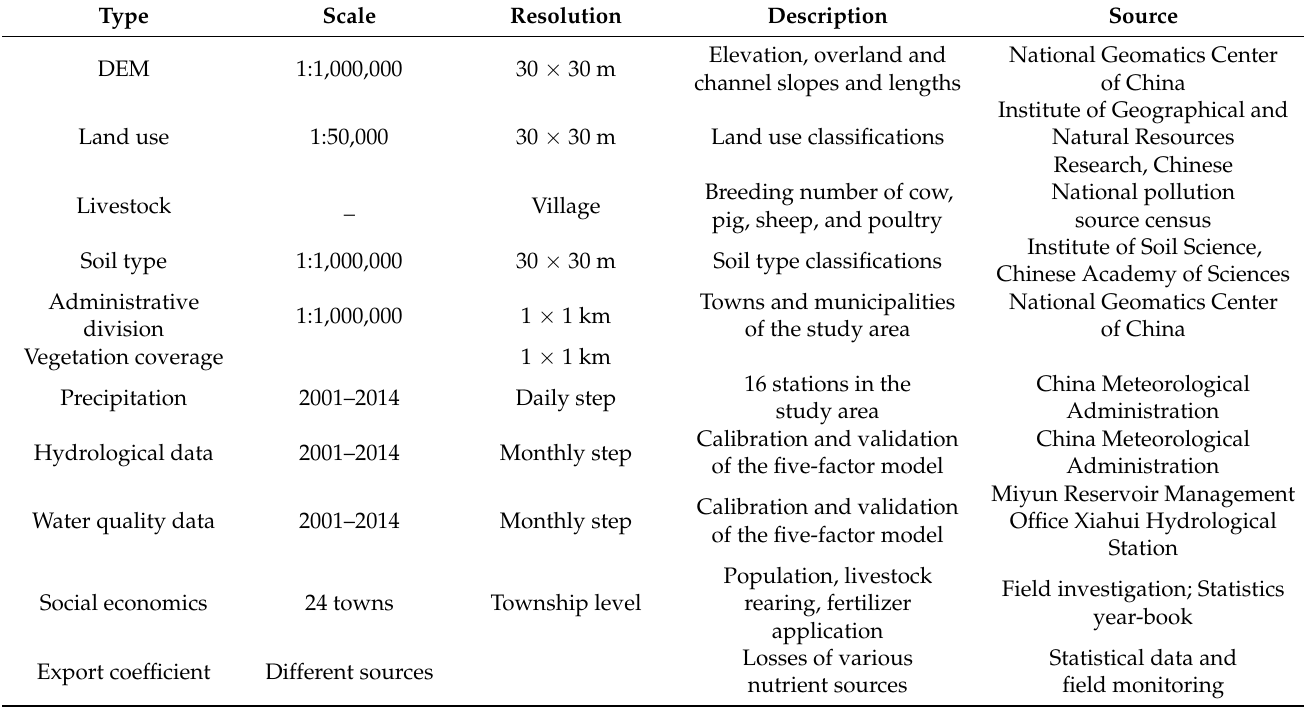
Table 1. Source and description of basic